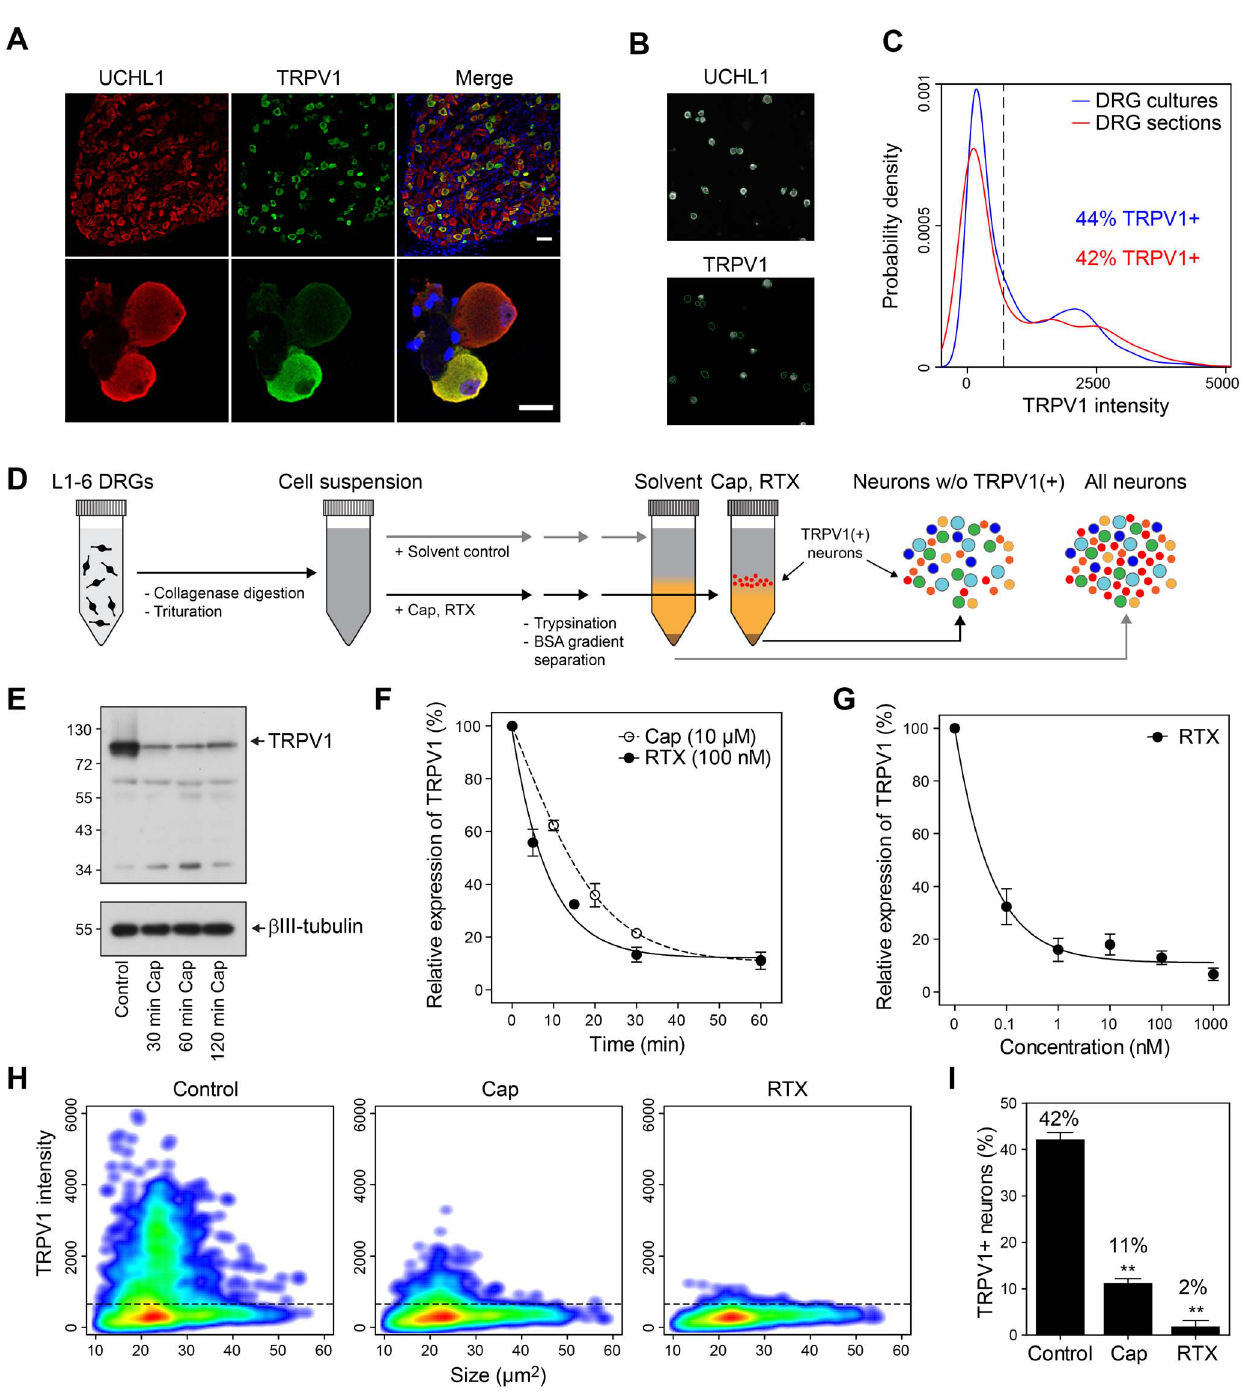
Fig. 1. Agonist-treatment enables the selective removal of TRPV1( + ) neurons. (A) Immunolabeling of the neuronal marker UCHL1 and TRPV1 in frozen DRG sections and cultured sensory neurons from rat. TRPV1 is selectively expressed in a subpopulation of sensory neurons. (B) Representative view field showing the automated image analysis to quantify TRPV1 expression in cultured sensory neurons. Green encircled objects represent sensory neurons marked by UCHL1. (C) Distribution of TRPV1 immunofluorescence intensities in frozen DRG sections (red line) and cultured sensory neurons (blue line). The scattered line indicates the threshold used to determine the number of TRPV1( + ) neurons. (D) Work flow to remove TRPV1( + ) neurons from freshly isolated sensory neurons. (E) Immunoblot showing the reduction of TRPV1 protein following depletion of TRPV1( + ) neurons with 10 m M capsaicin for 30– 120 min. (F) Time-dependent reduction of TRPV1 mRNA after removal of TRPV1( + ) neurons with 10 m M capsaicin or 100 nM RTX determined by qPCR.